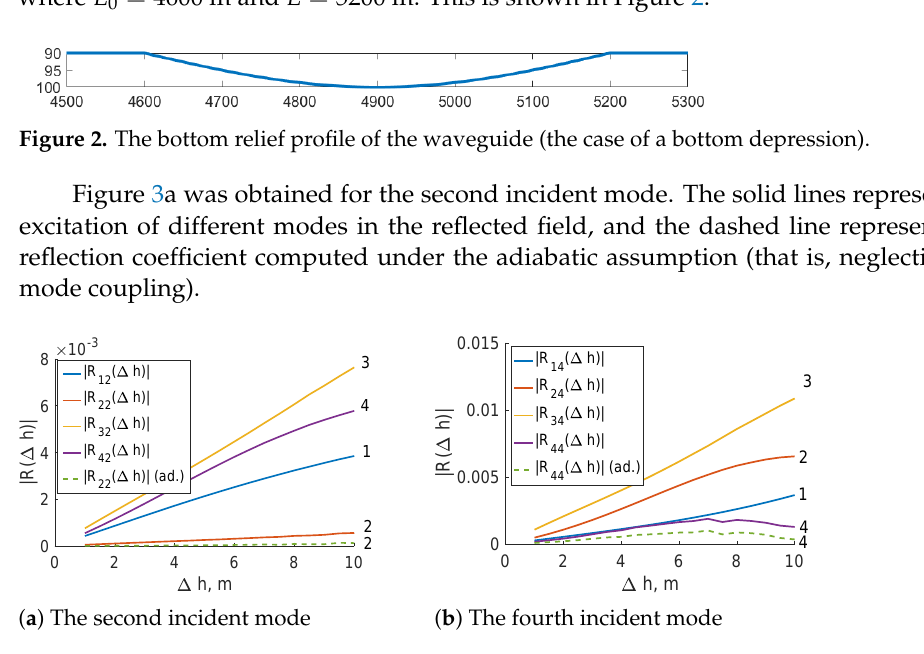
Figure 3. The reflection coefficients as functions of the maximum depth change ∆ h associated with the inhomogeneity.